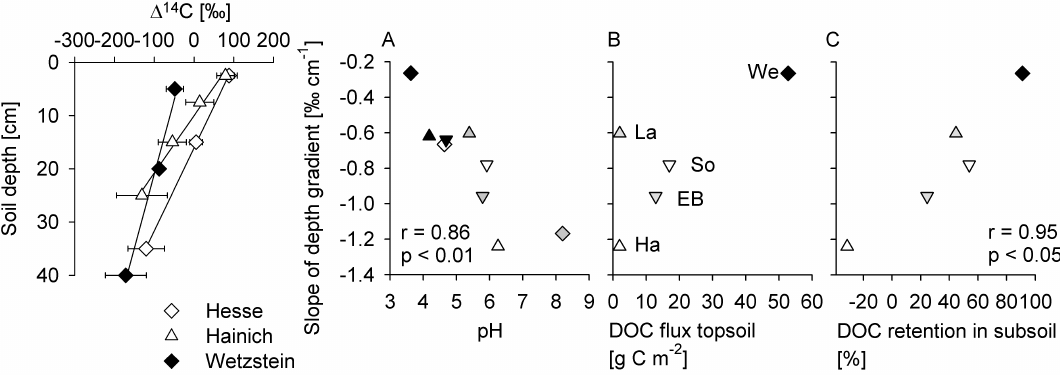
Fig. 14. Relation between the slope of the decline of HF 1 14 C with soil depth and (A) pH values of the upper 30cm of the soil, (B) dissolved OC fluxes in the topsoil (values taken from Kindler et al., 2011), and (C) OC retention in the subsoil (values taken from Kindler et al., 2011). (La: Laqueuille, We: Wetzstein, So: Sorø, EB: Easter Bush, Ha: Hainich, black: coniferous forest, dark grey: croplands, light gray: grasslands, white: deciduous